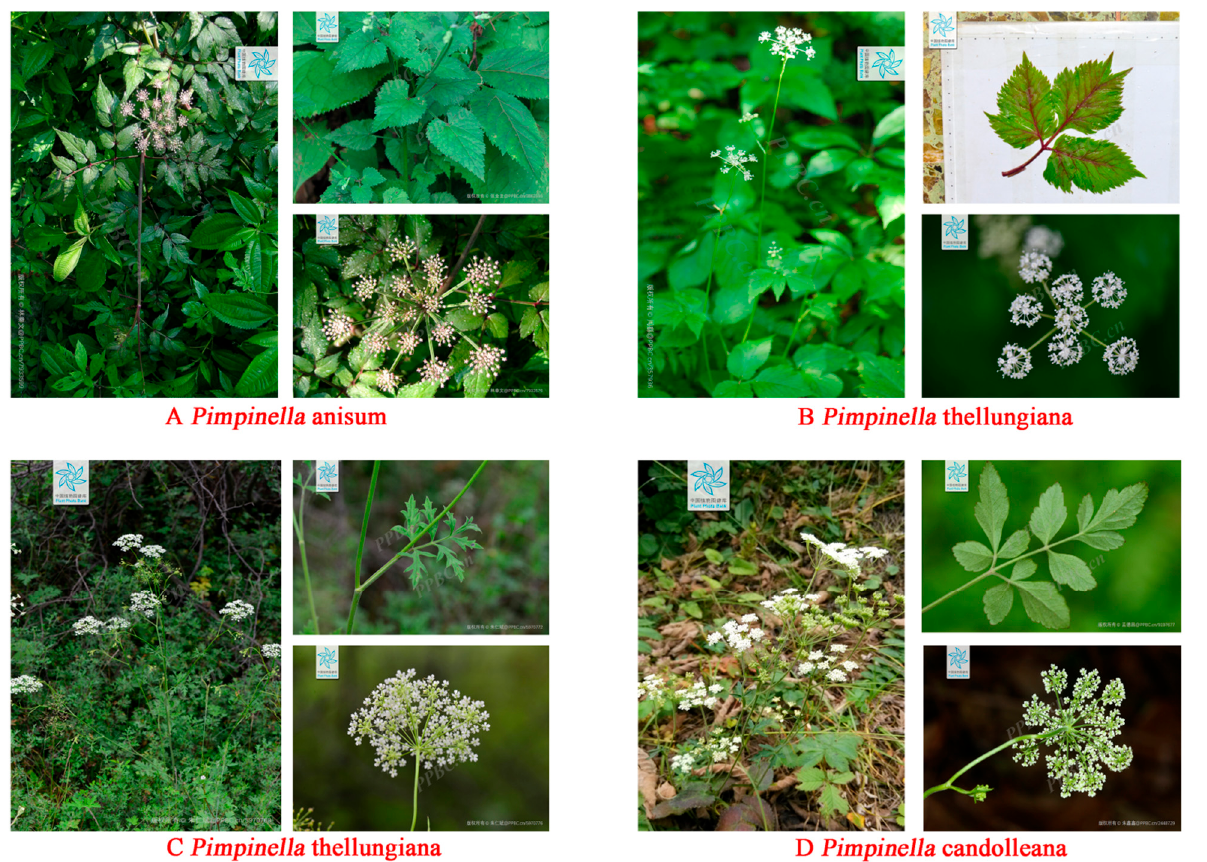
Figure 1. Morphological characteristics of several major Pimpinella species: ( A ), Pimpinella anisum ; ( B ), Pimpinella brachycarpa ; ( C ), Pimpinella thellungiana ; ( D ), Pimpinella candolleana (Cited from http://ppbc.iplant.cn, (accessed on 8 June 2022)).